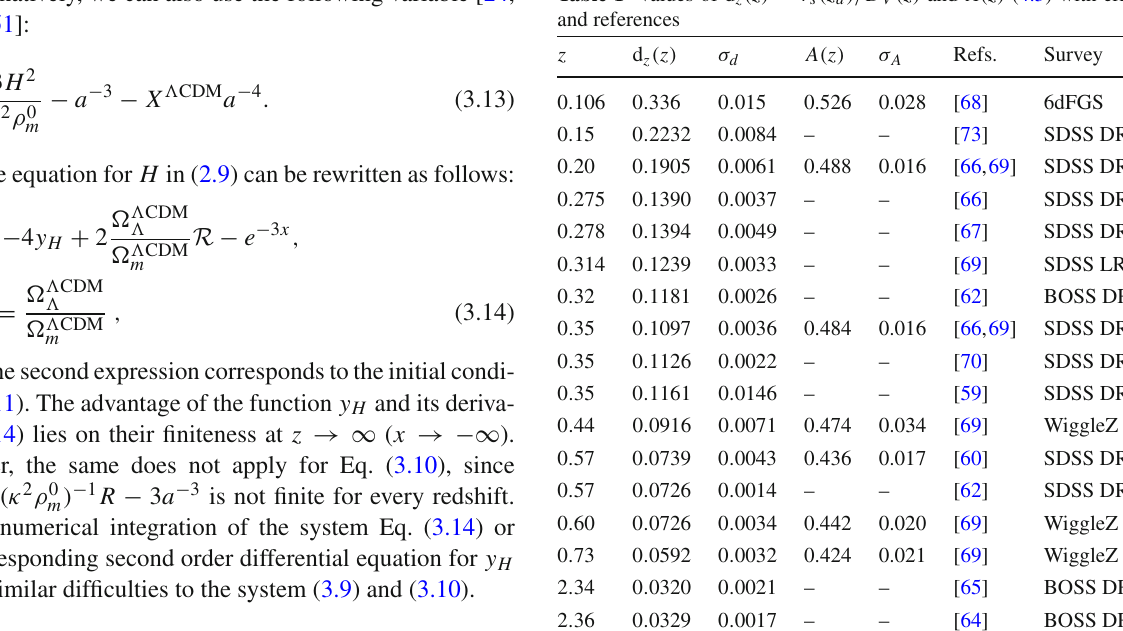
Table 1 Values of d z ( z ) = r s ( z d )/ D V ( z ) and A ( z ) (4.5) with errors